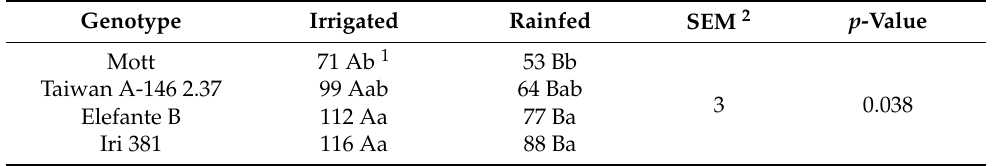
Table 5. Leaf lignin (g/kg dry matter) as affected by the interaction between irrigation and genotype for elephantgrass genotypes at Garanhuns, Pernambuco,